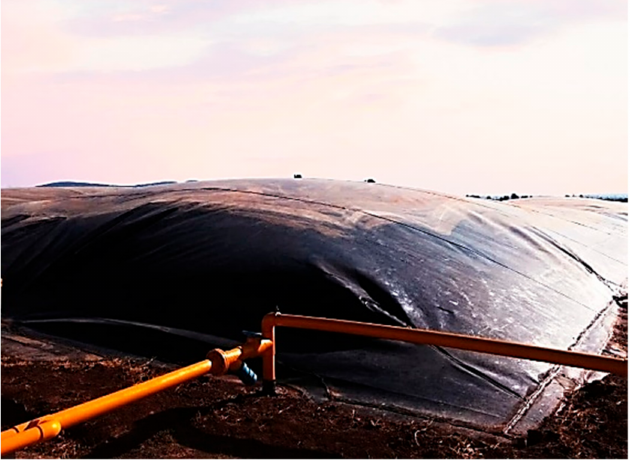
Figure 2. Lagoon